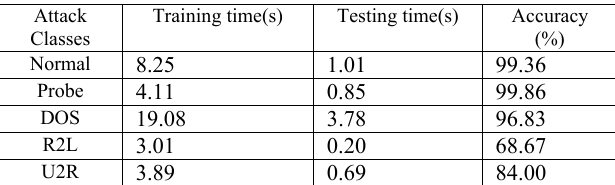
Table 6. Performance of the C4.5 classifier